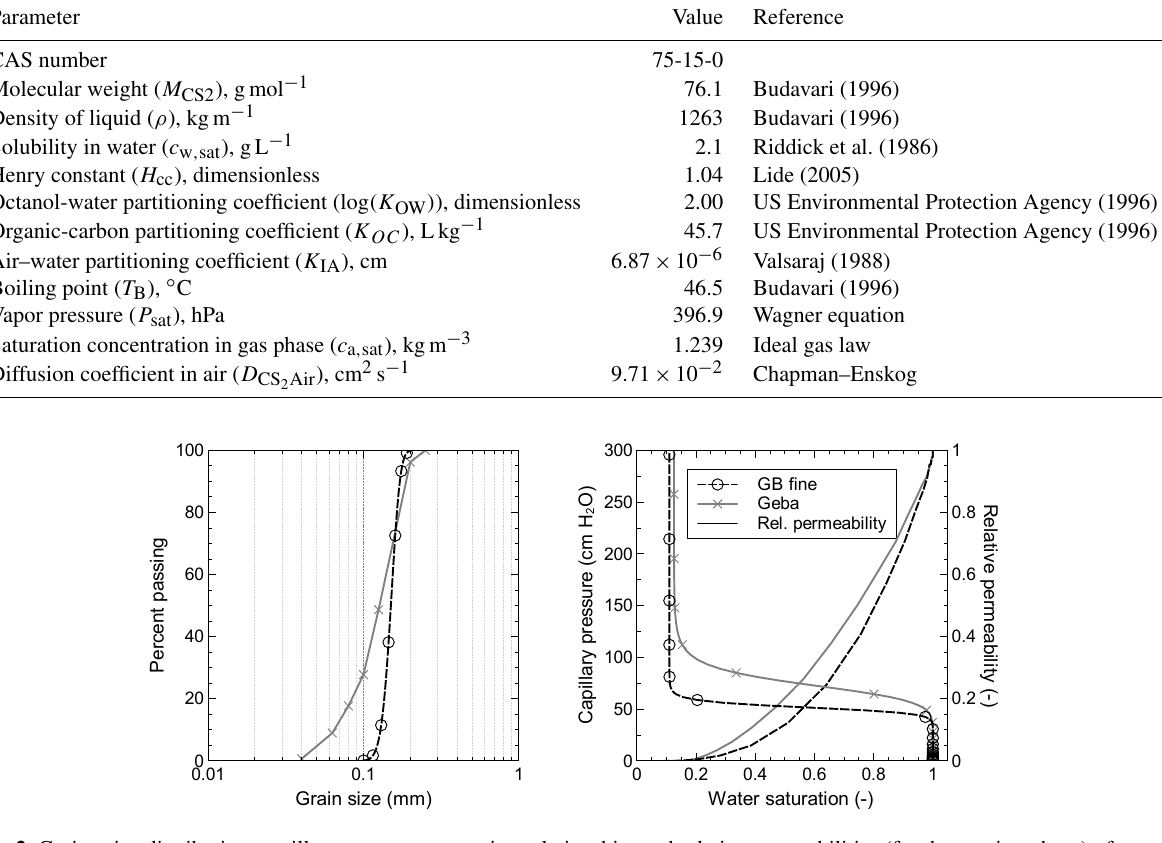
Figure 2. Grains-size distribution, capillary pressure–saturation relationship, and relative permeabilities (for the wetting phase) of materials used in experiments.